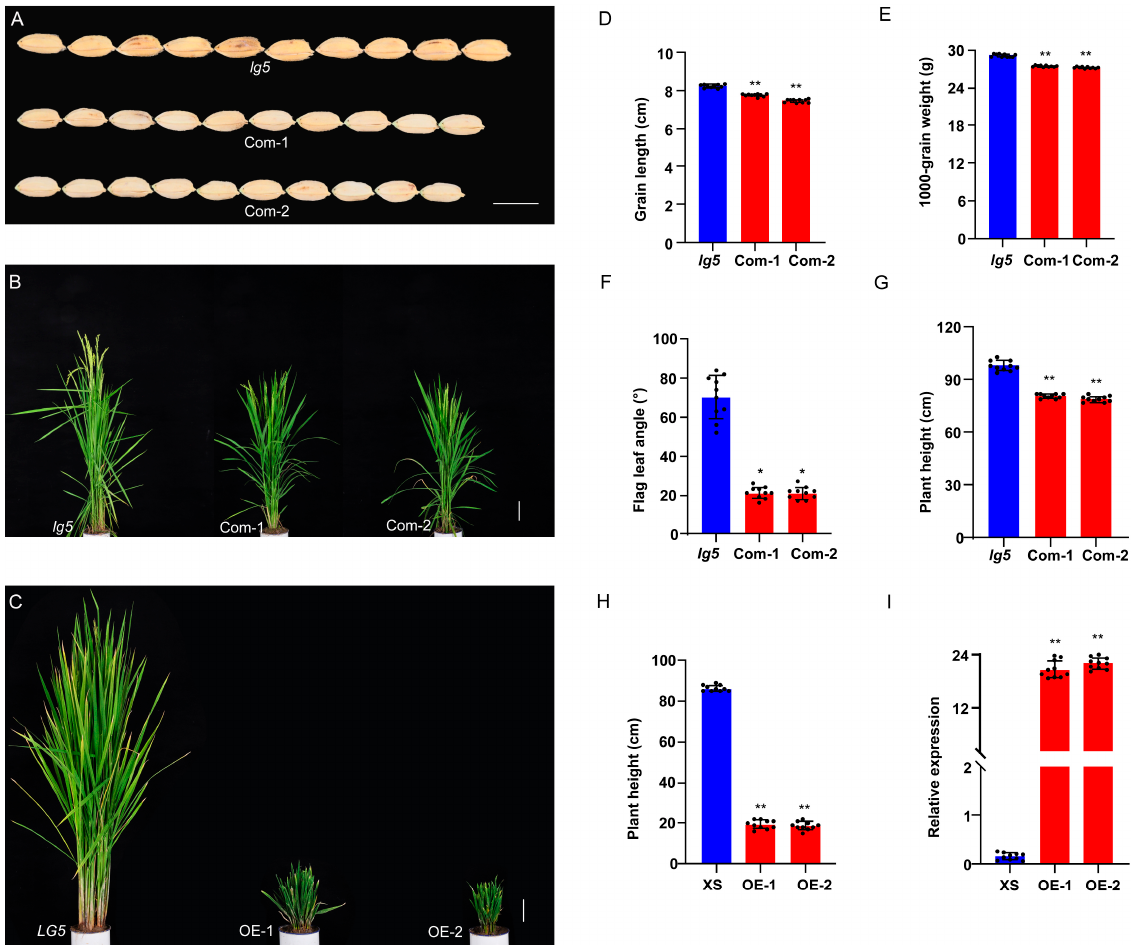
Figure 3. Complementary test and overexpression (OE) analysis at the mature stage. ( A ) Grain length of lg5 and Com; bar = 8 mm. ( B ) Plant height of lg5 and Com; bar = 10 cm. ( C ) Plant height of XS and OE; bar = 10 cm. ( D – G ) Grain length, thousand-grain weight, flag leaf angle, and plant height of lg5 and Com. ( H ) Plant height of XS and OE. ( I ) Relative expression of LG5 in culms of XS and OE with the rice ACTIN gene used as an internal control. Data are presented as means ± SD. * and ** indicate p < 0.05 and p < 0.01, respectively, according to Student’s t -test.